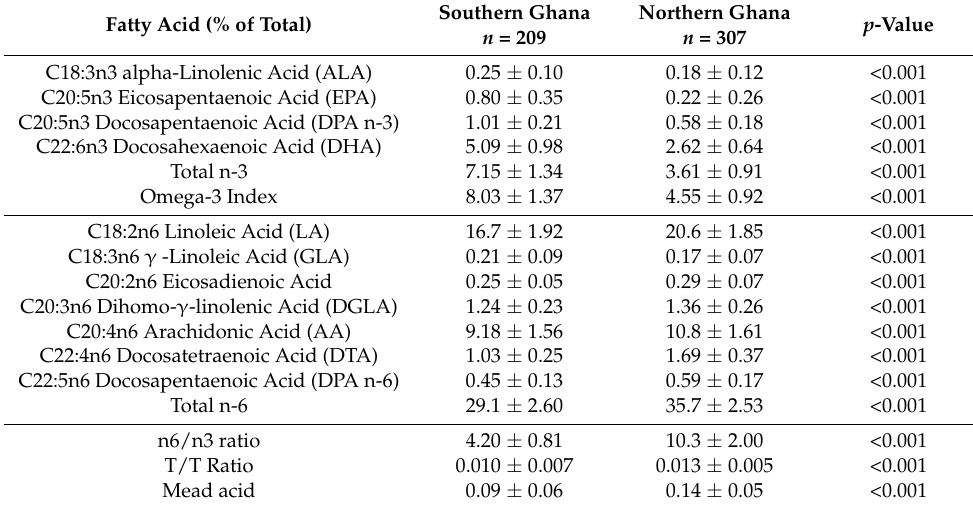
Table 7. Mean percent FA levels for northern and southern Ghanaian